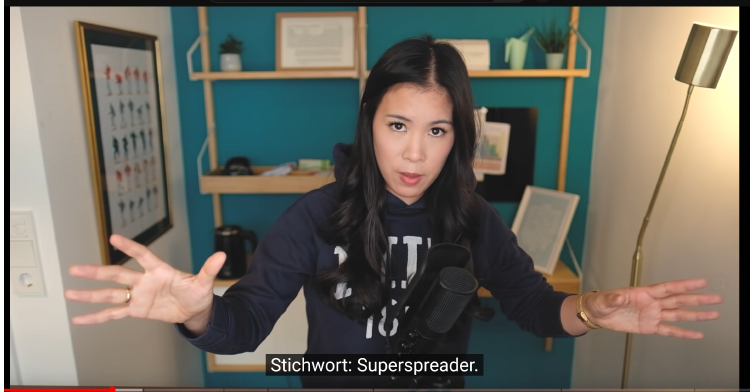
Figure 2. Example for a presentation video: Channel maiLab on YouTube.